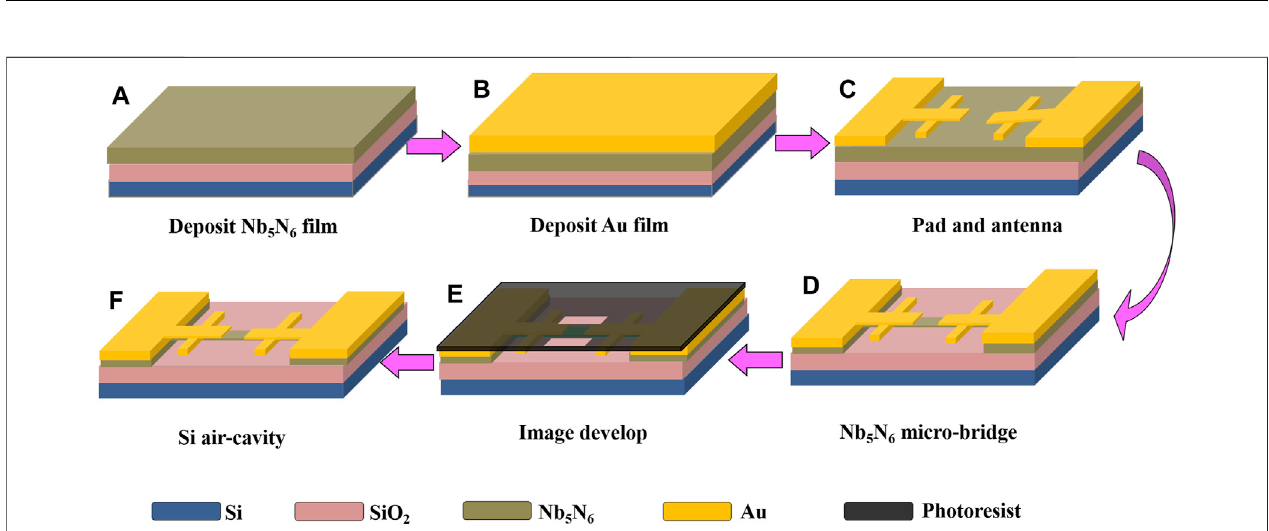
FIGURE 3 | The fabrication process of the Nb 5 N 6 THz detector integrated with RF choke-enhanced dipole antenna.